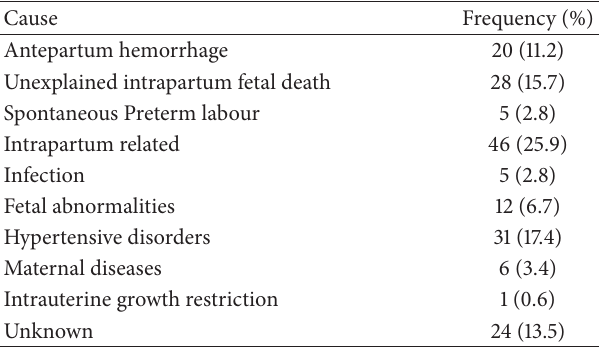
Table 2: Baird-Pattinson classification of causes of fetal death, 𝑛 =